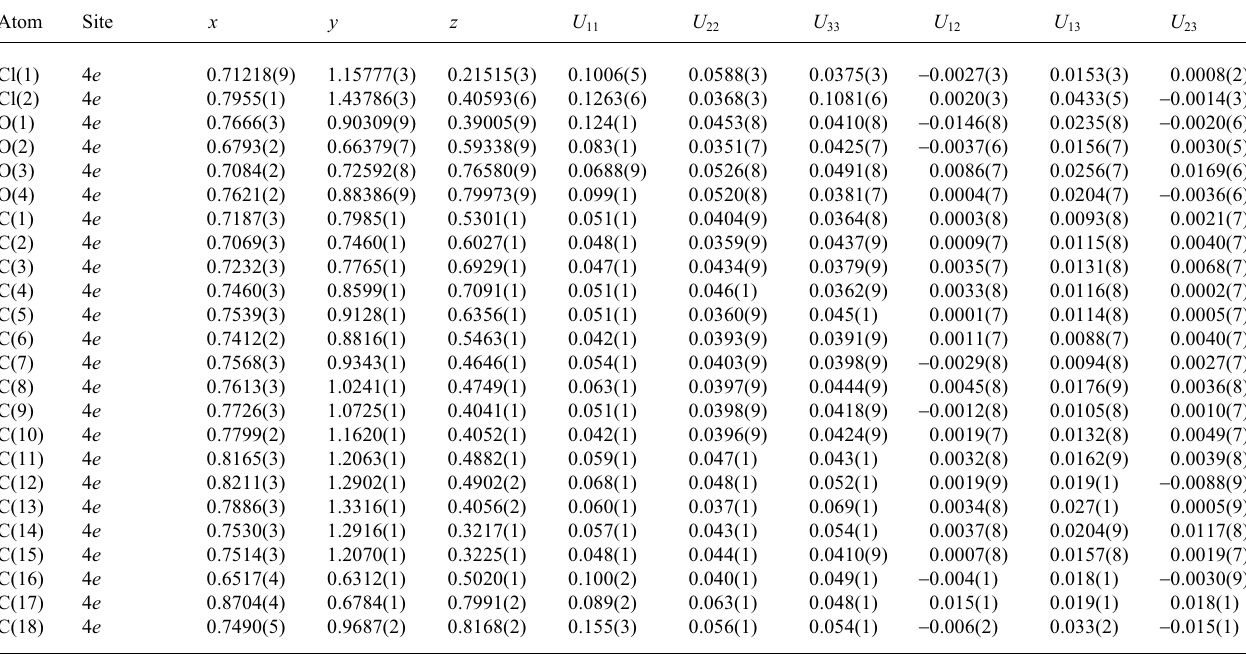
Table 3. Atomic coordinates and displacement parameters (in Å 2